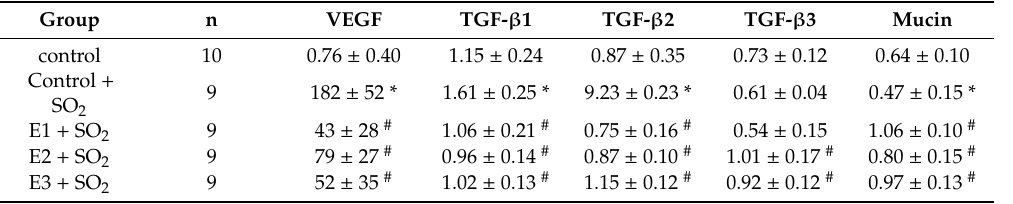
Table 4. Influence of di ff erent extracts from Platycodon grandiflorum A. DC on VEGF, TGF- β 1, TGF- β 2, TGF- β 3, and mucin (MUC5AC) mRNA expression in rats’ bronchi.